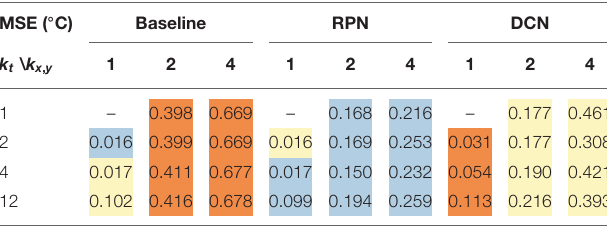
TABLE 1 | Temperature ( ◦ C) downscaling mean-squared errors (MSE), coloring the best ( • ), intermediate ( • ) and worst ( • ) result. MSE ( ◦